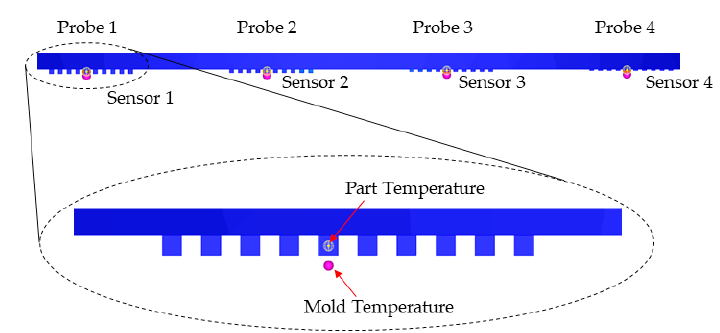
Figure 13. Probe and sensor nodes for monitoring part and mold temperature in the microfeatures.